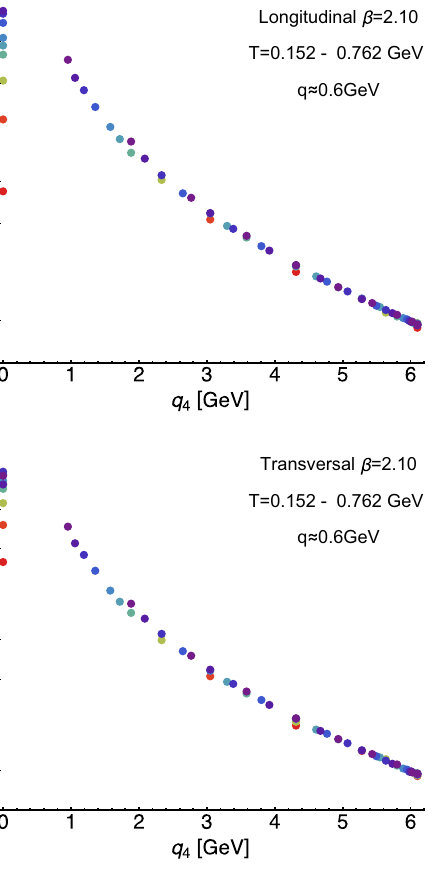
while the right panel shows those at | q | ≈ 1 . 5 GeV. Note that above the first finite Matsubara frequency all data points essentially line up on the same T = 0